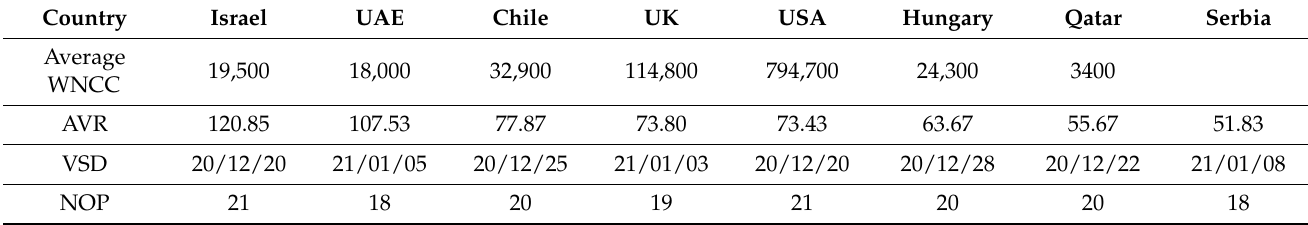
Table 1. The descriptive statistics among countries selected.